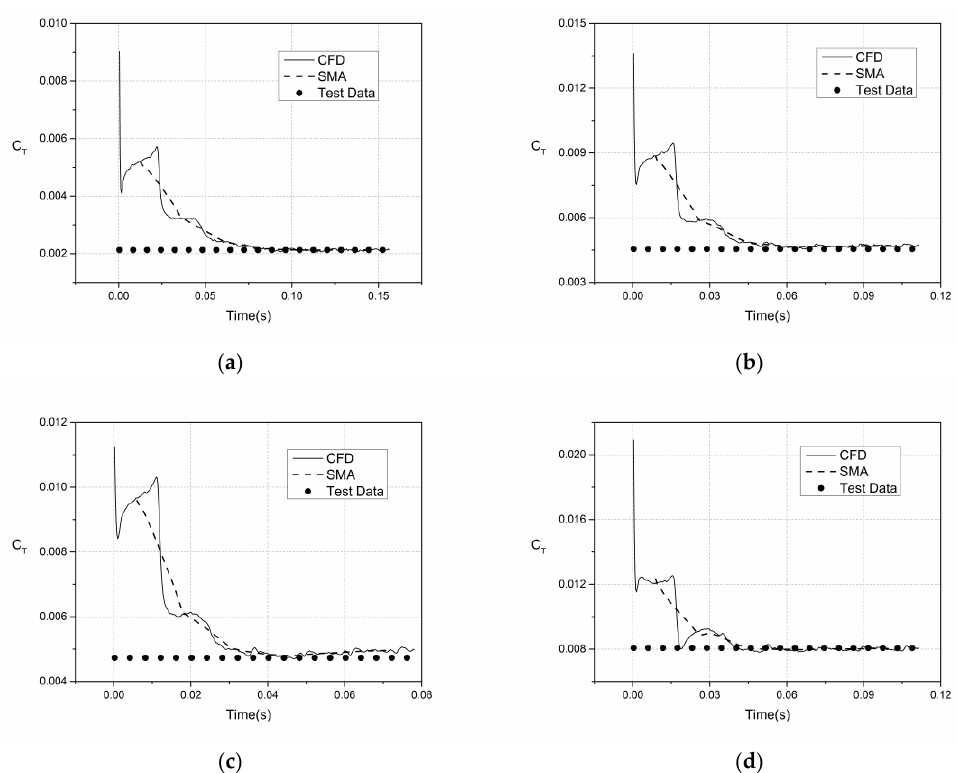
Figure 6. C-T rotor thrust coefficient curve with physical time. ( a ) 𝑀 𝑡𝑖𝑝 = 0.433 ， 𝜃 𝑐 = 5° . ( b ) ◦ . ( c ) M = 0.877, θ c = 8 ◦ . ( d ) M 𝑀 𝑡𝑖𝑝 = 0.612 ， 𝜃 𝑐 = 8° . ( c ) 𝑀 𝑡𝑖𝑝 = 0.877 ， 𝜃 𝑐 = 8° . ( d ) 𝑀 𝑡𝑖𝑝 = 0.612 ， 𝜃 𝑐 = 12° . θ c = 8 tip